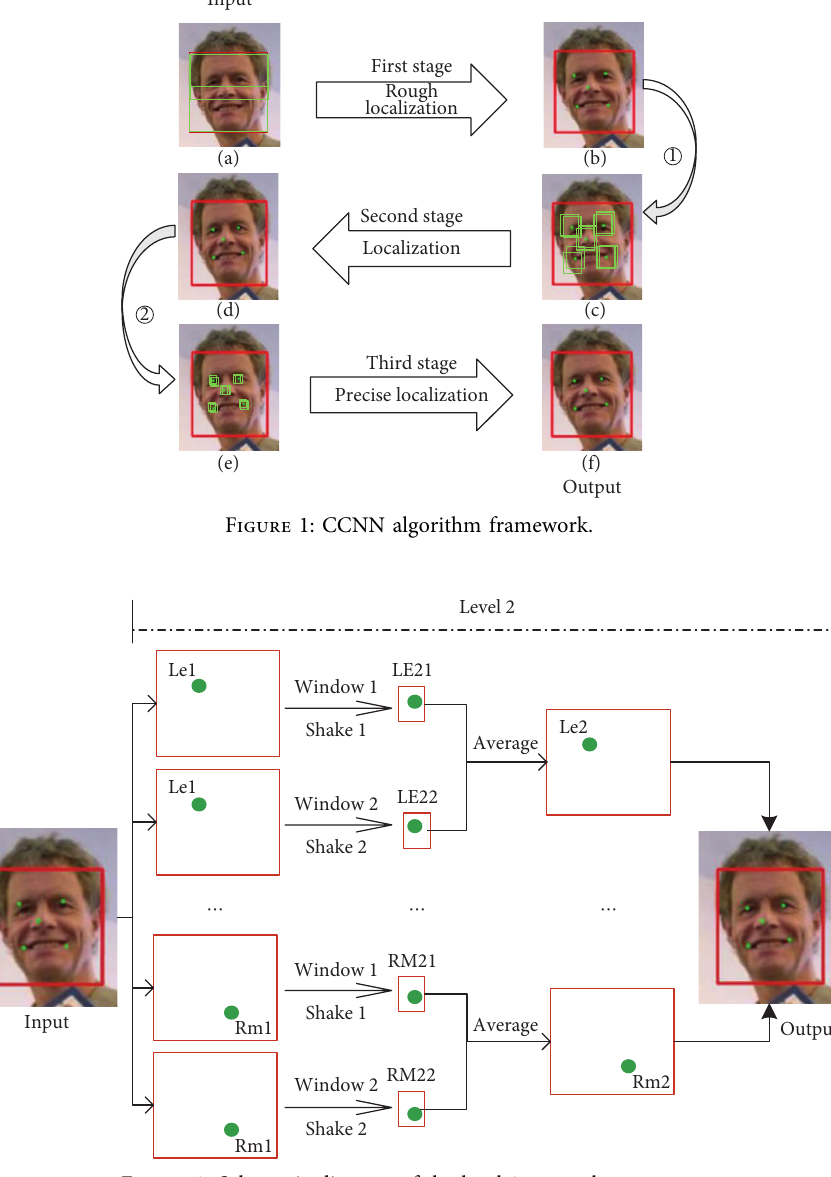
Figure 2: Schematic diagram of the level 2 network structure.